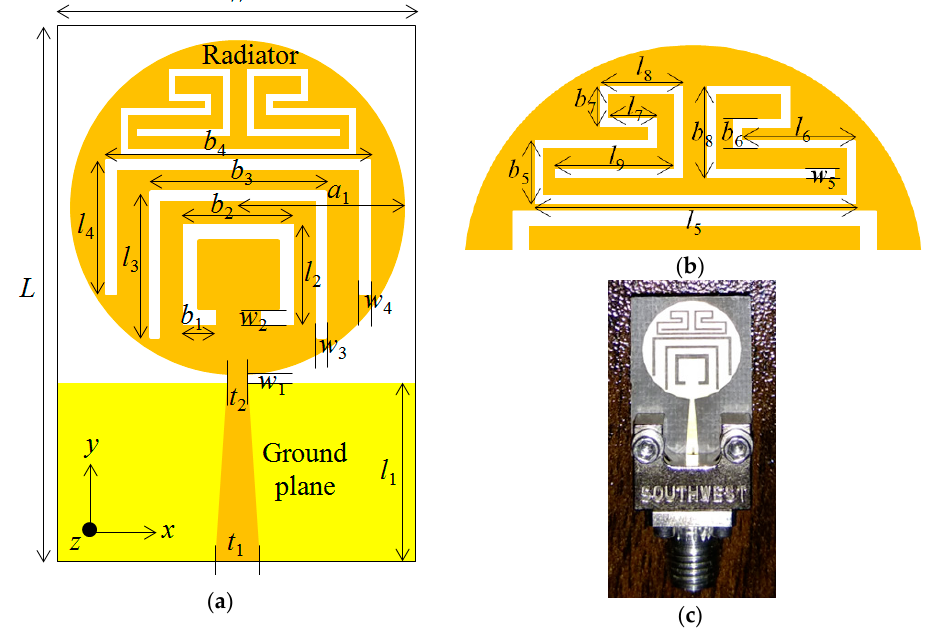
Figure 1. Proposed quad band-notched super-wideband (SWB) antenna: ( a ) schematic, ( b ) enlarged view of the meandered slot, ( c ) fabricated prototype. Table 1. Dimensions of the proposed quad band-notched super-wideband (SWB) antenna.